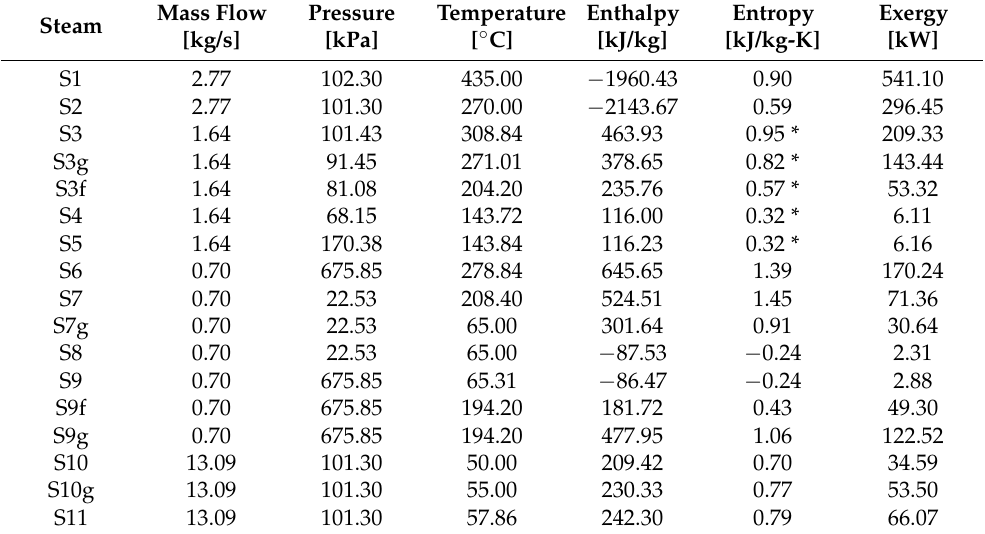
Table 7. Thermodynamic properties for each system flow.